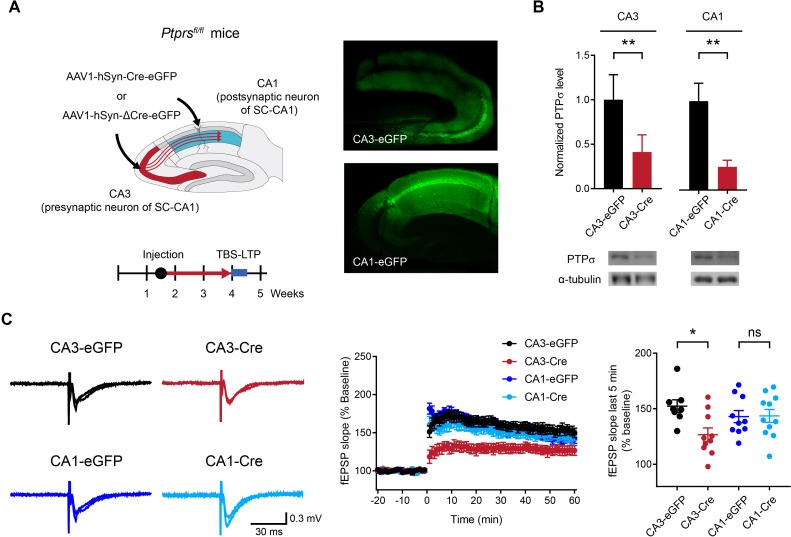
Deletion of presynaptic, but not postsynaptic, PTPσ suppresses TBS-LTP at SC-CA1 synapses.(A) Diagram depicting deletion of presynaptic PTPσ in the CA3 region or postsynaptic PTPσ in the CA1 region, induced by local injection of AAV1-hSyn-Cre-eGFP (Cre recombinase fused to EGFP); mice injected with AAV1-hSyn-ΔCre-eGFP (lacking Cre) served as controls. TBS-LTP experiments were conducted ~2.5 weeks later. Local expression of Cre recombinase was further confirmed by EGFP fluorescence in controls co-injected with AAV1-hSyn-eGFP (right) and by reduced PTPσ protein levels (panel B). (B) Decreased PTPσ protein levels in CA3 and CA1 regions of Ptprsfl/fl mice injected with AAV1-hSyn-Cre-eGFP (CA3/CA1-Cre) compared with those in Ptprsfl/fl mice injected with AAV1-hSyn-ΔCre-eGFP (CA3/CA1-EGFP). (n = 5 mice [CA3-eGFP], 5 [CA3-Cre], 4 [CA1-eGFP] and 3 [CA1-Cre], *p<0.05, **p<0.01, one-sample t-test). (C) Suppressed TBS-LTP at SC-CA1 synapses of Ptprsfl/fl mice (4 weeks) induced by knocking out PTPσ in the CA3 region (but not CA1 region) by local injection of AAV1-hSyn-Cre-eGFP, compared with TBS-LTP in control Ptprsfl/fl mice injected with AAV-hSyn-ΔCre-eGFP. (n = 8 slices from five mice [CA3-eGFP], 10, 4 [CA3-Cre], 10, 4 [CA1-eGFP] and 11, 5 [CA1-Cre], *p<0.05, ns, not significant, two-way ANOVA with Sidak’s test).